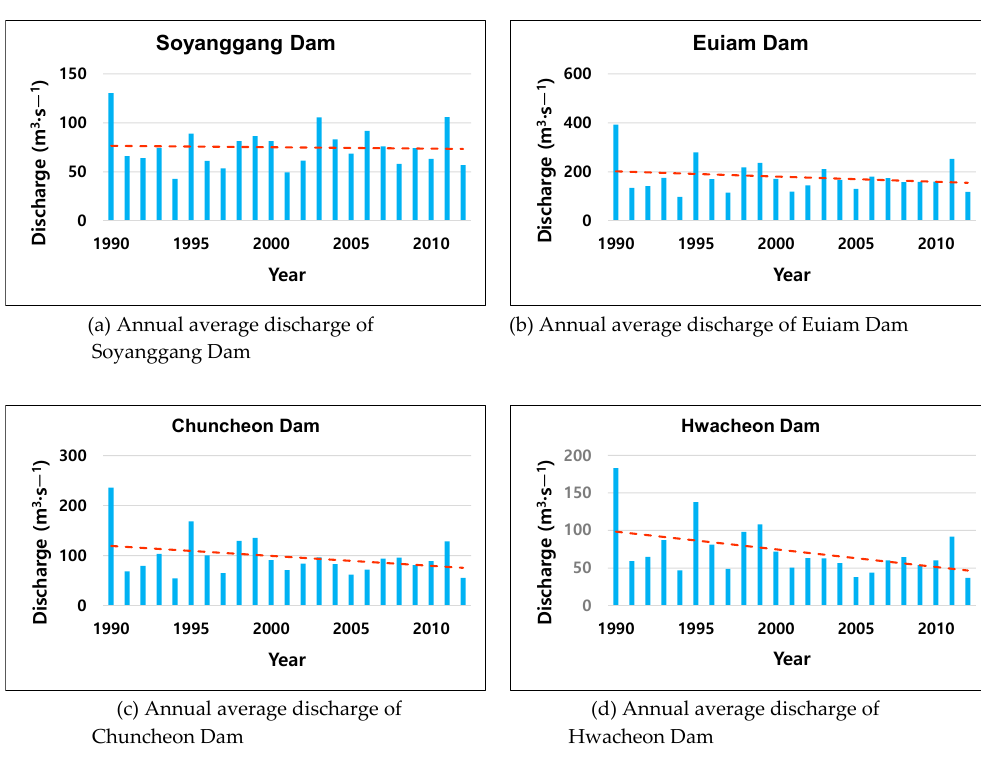
Figure 4. Annual average discharges in four dams (( a ) Soyanggang, ( b ) Euiam, ( c ) Chuncheon, and ( d ) Hwacheon Dams) during 1990–2012.